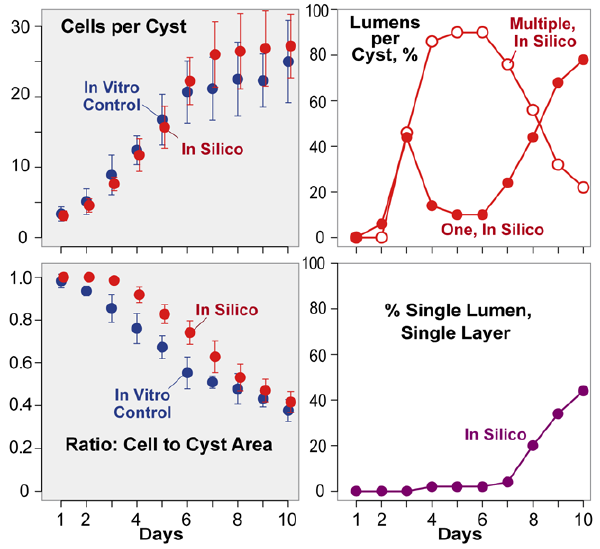
Figure 8. C YSTOGENESIS measures when CELL POLARIZATION was delayed. ISMA simulations executed with the parameters values from Table 2 except that CELL POLARIZATION was delayed as described in the text. Left: mean values and standard deviations for CELL number per CYST (top panel) and ratio of CELLULAR to CYST area (bottom panel). Right: Percentage of CYSTS with single, multiple, and SLSL lumens. Designations and symbols are the same as in Figures 2 and 3.